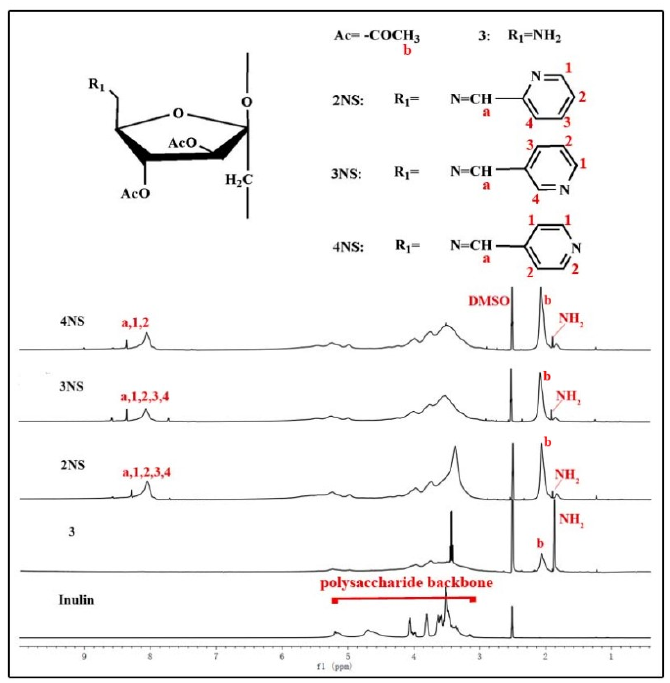
Figure 3. 1 H nuclear magnetic resonance ( 1 H NMR) spectra of inulin and the inulin